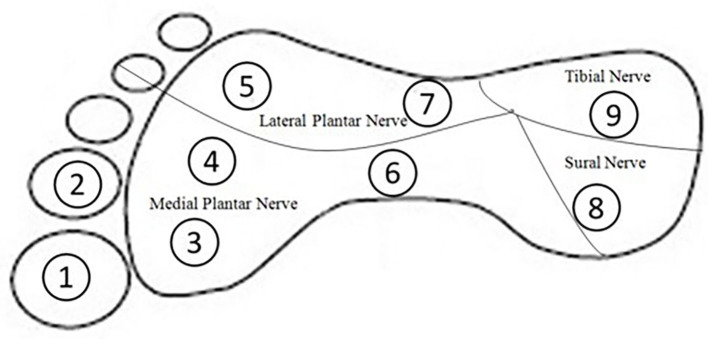
Foot stimulation positions evaluated by Semmes–Weinstein-type pressure aesthesiometer.